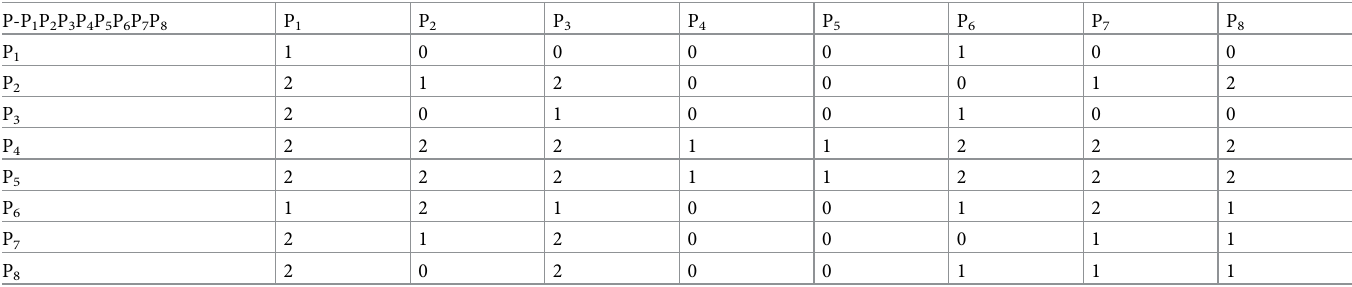
Table 4. Pressure comparison matrix.